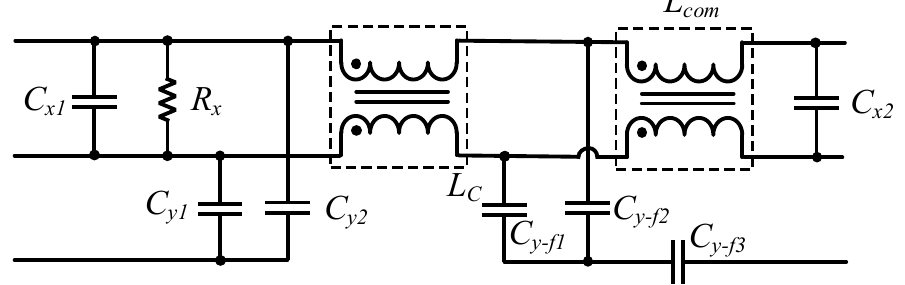
Figure 11. EMI filter with the combination L CM and L DM .